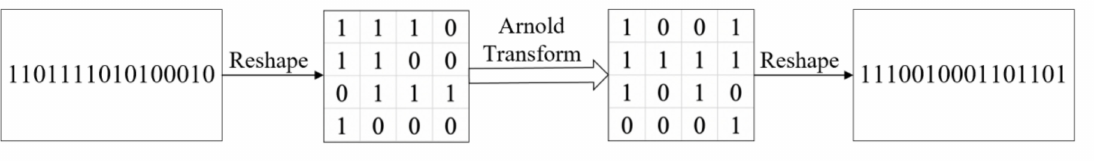
Figure 3. Demonstration of watermark scrambling.